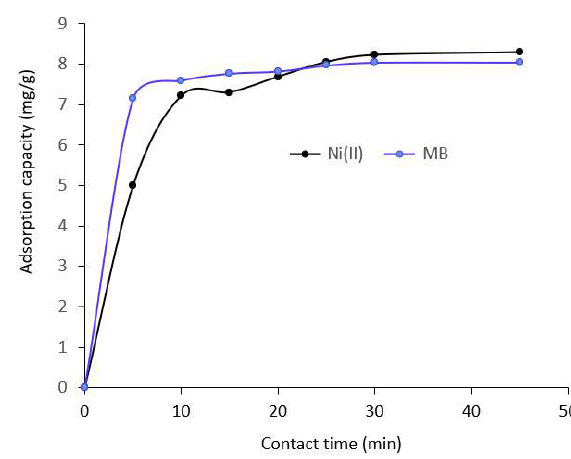
Fig.7. The effect of contact time on the adsorption uptake capacity of clay for Ni (II) ions and